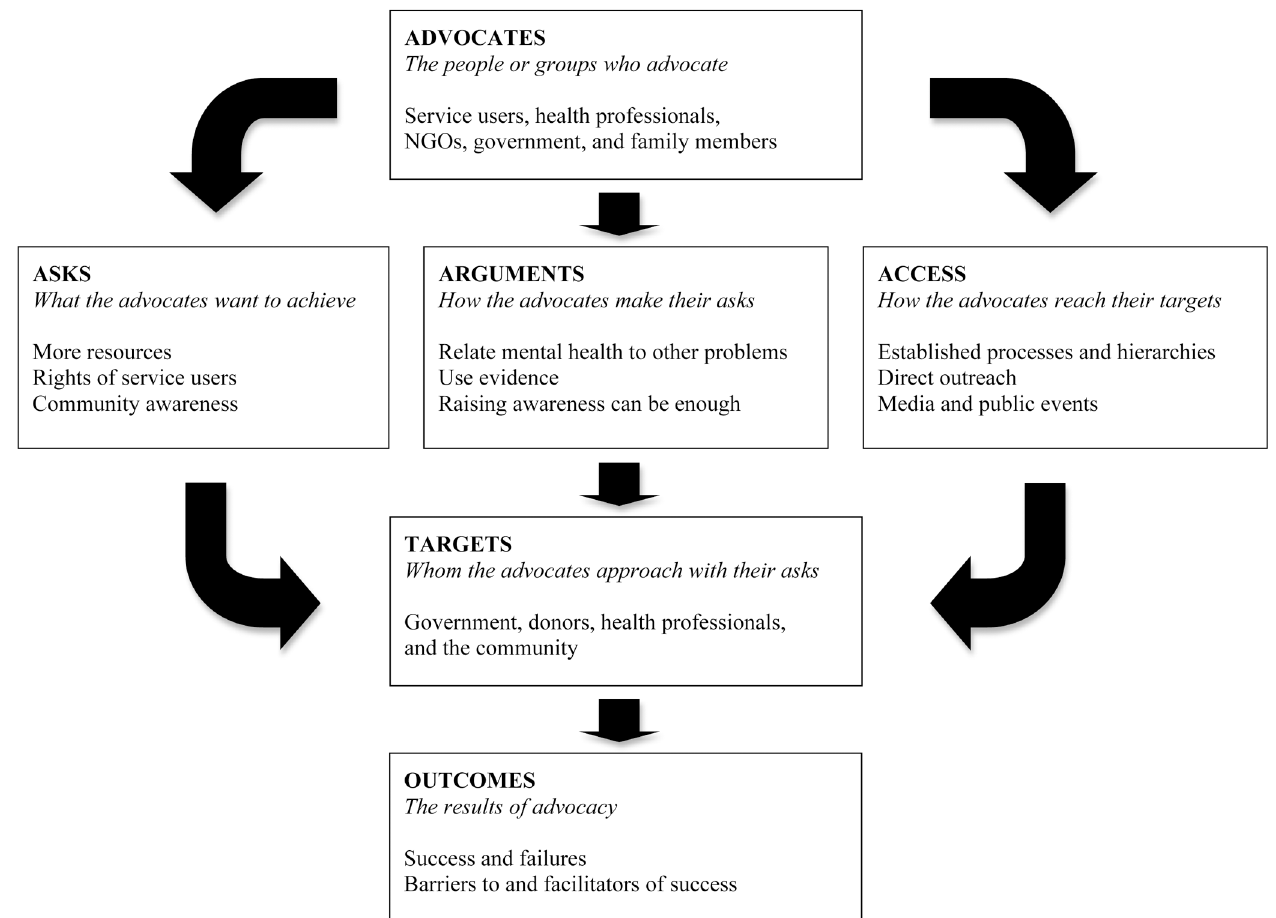
Fig 1. Postulated relationship between components of advocacy respondents